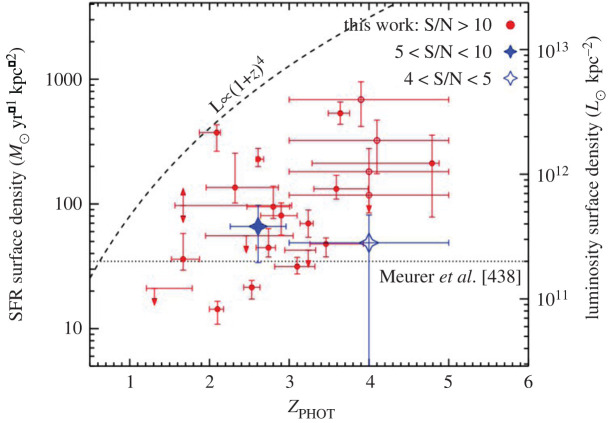
Star formation rate density versus redshift for the FIR-bright SMG sample from Simpson et al. [252]. The dashed line indicates luminosity evolution LIR ∝ (1+z)4, and the dotted line shows the 90th percentile of the luminosity surface density for a sample of UV-selected sources [438]. Taking the extent of the FIR emission as a proxy for the extent of the dusty star formation, the newly measured FIR sizes for large samples of high-redshift sources have allowed the global star formation rate surface densities to be constrained. The resultant values are largely below the Eddington limit for a radiation pressure supported starburst (approx. 1000 M⊙ yr−1 kpc−2; [435], though note that the precise value depends on the physical conditions of the source, including optical depth). Figure from Simpson et al. [252].